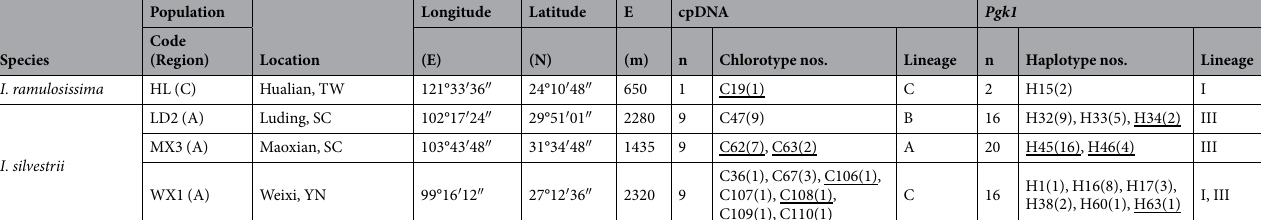
Table 1. Locations of populations of Indigofera bungeana complex sampled, sample sizes (n), frequencies of chloroplast and Pgk1 haplotypes per population, the geographic region (Figs 1 and 2) and lineage (Figs 3a and 4a) for each population. Frequencies of chlorotypes and Pgk1 haplotypes are shown in parentheses. Private haplotype particular to each population are underlined. Abbreviations: HEN, Henan; SC, Sichuan; HUB, Hubei; SX, Shanxi; SHX, Shannxi; ZJ, Zhejiang; JX, Jiangxi; GZ, Guizhou; BJ, Beijing; YN, Yunnan; AH, Anhui; SD, Shandong; JS, Jiangsu; IM, Inner Mongolia; FJ, Fujian; GX, Guangxi; CQ, Chongqing; HEB, Hebei; HUN, Hunan; Taiwan, TW.